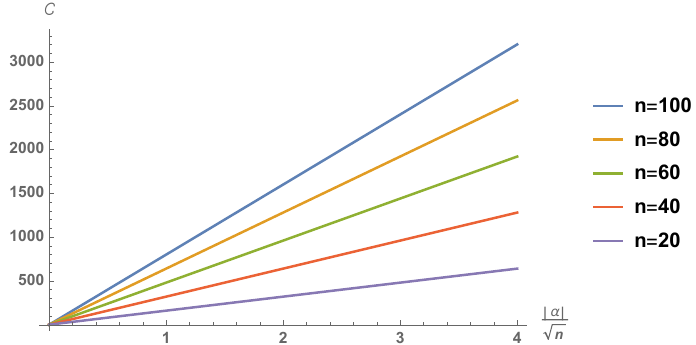
Figure 2. Complexity where n labels the bosonic excitation b y B ( n ) is set equal to 10 n .